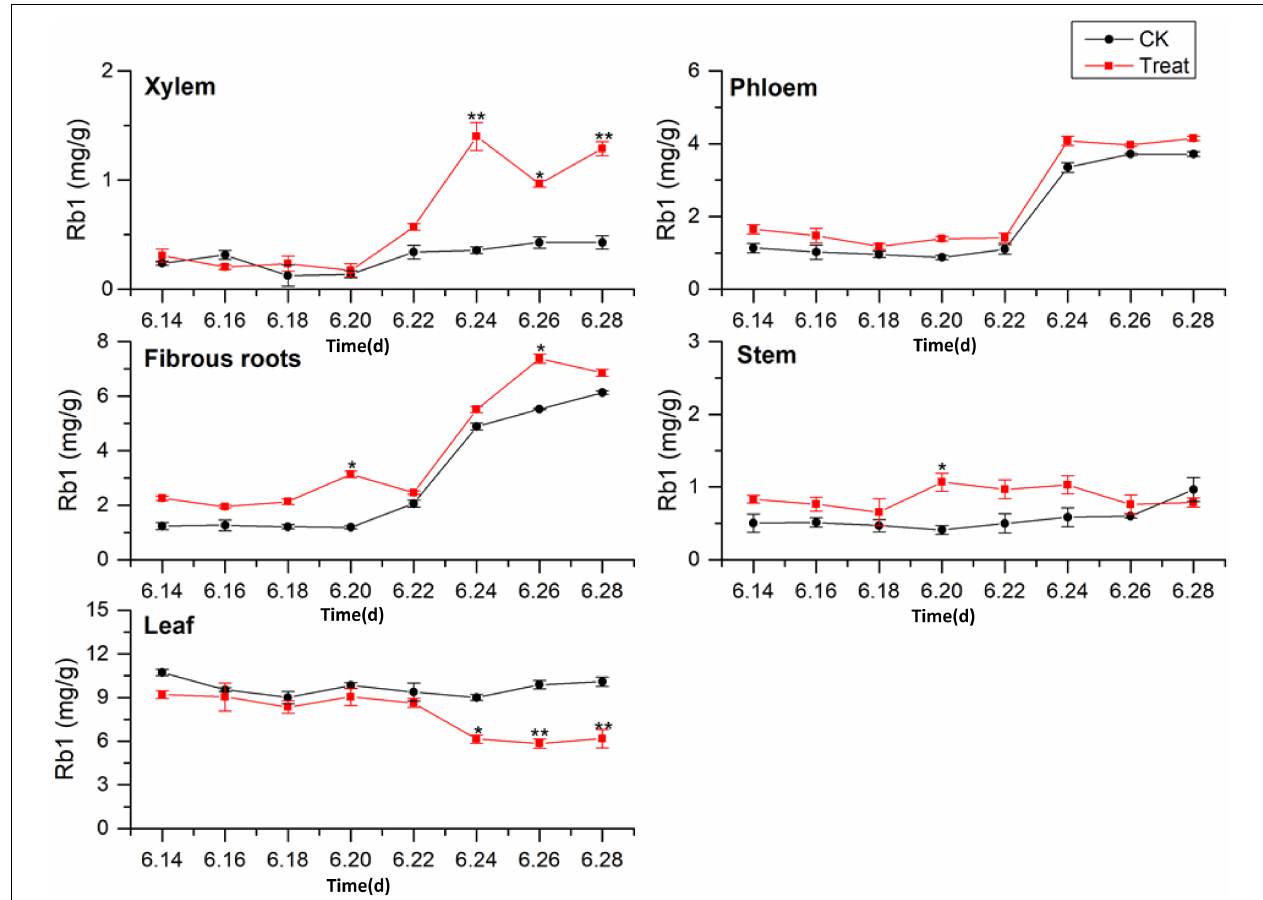
FIGURE 4 | Effects of cold stress on Rb1 in different tissues of flowering ginseng. The X axis represents the sampling time. * p < 0.05 and ** p < 0.01, compared with control group. The data are expressed as the mean ± SD ( n =